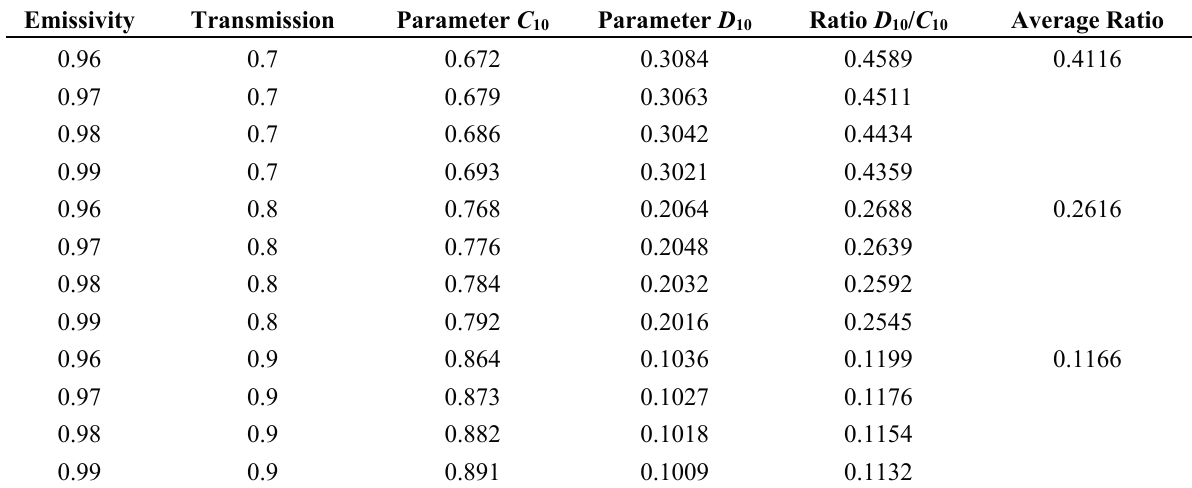
Table 9. Comparison of the ratio D 10 / C 10 for different